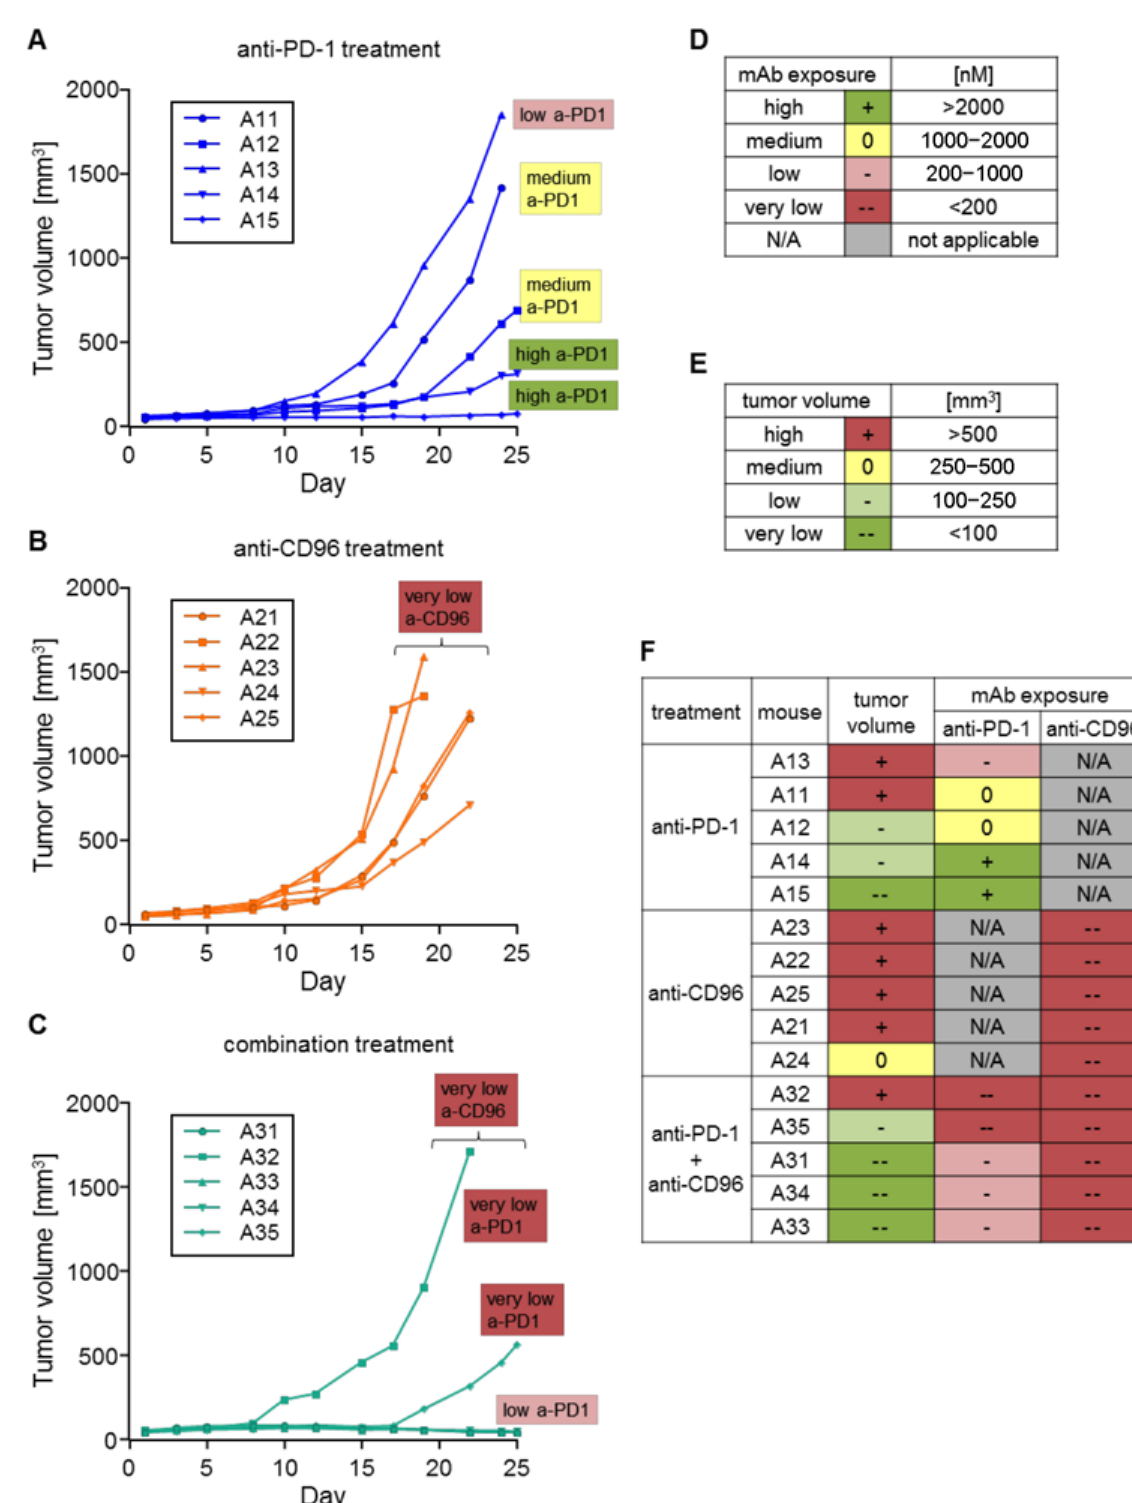
Figure 7. Comparison of tumor growth with mAb exposure. An increase in tumor volume is shown for mice treated with ( A ) anti-PD-1; ( B ) anti-CD96; and ( C ) the combination of anti-PD-1 and anti-CD96. ( D ) Categorizations of antibody exposure; ( E ) categorizations of tumor size; ( F ) comparison of antibody exposure (measured at day 18) with tumor size (measured at day 19). Mice are sorted by treatment groups and tumor sizes at day 19.